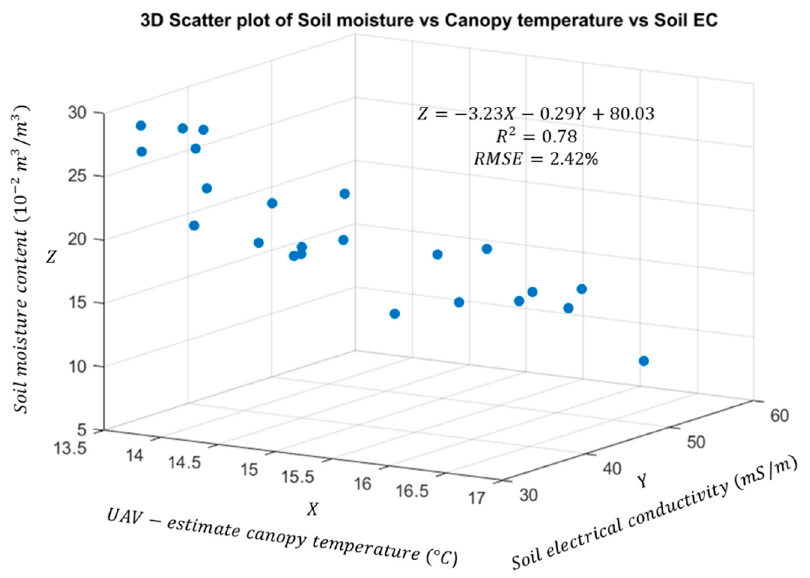
Figure 9. Correlation analysis between canopy temperature and soil properties (moisture content and soil ECa) across all 24 experimental plots.